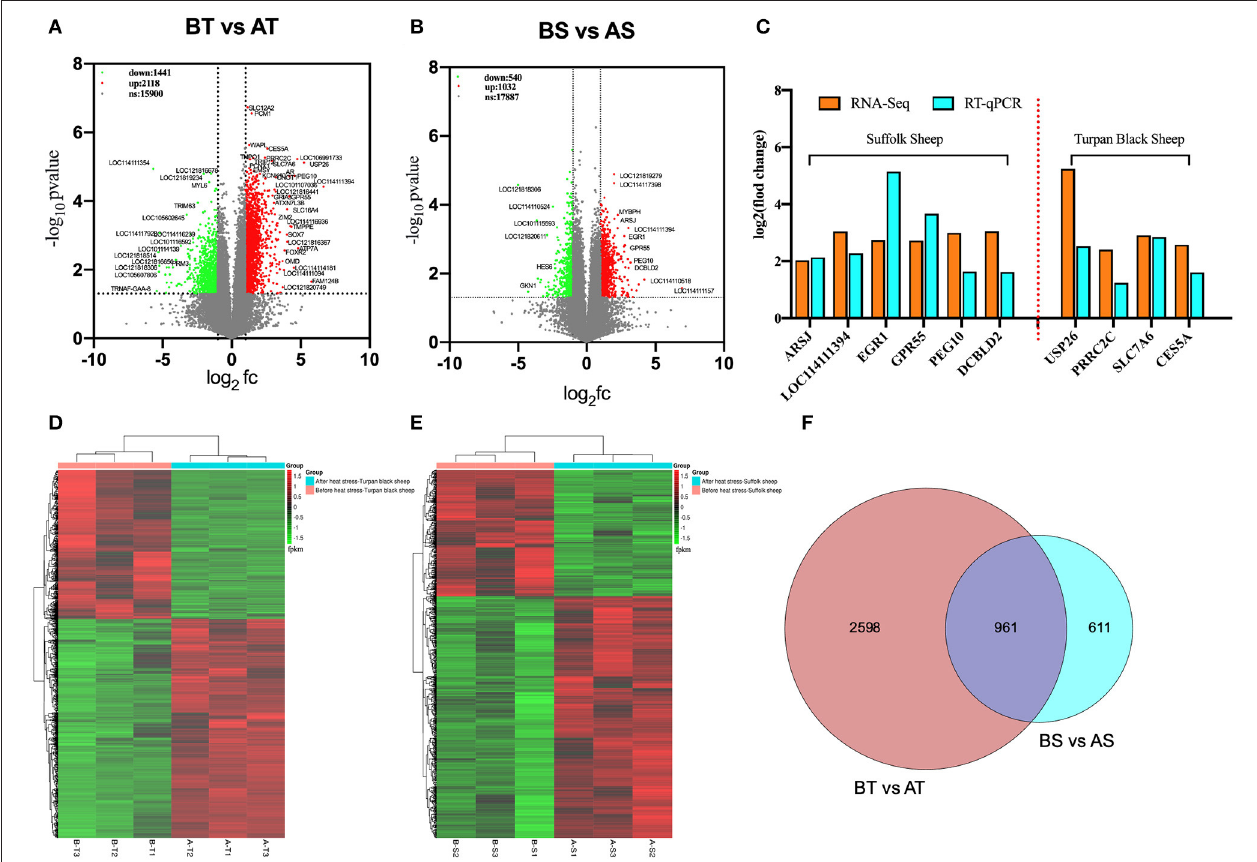
FIGURE 6 | Cluster analysis of differentially expressed genes in the testis transcriptome of Turpan black sheep before and after HS treatment. (A,D) Volcano map and heat map of testicular transcriptome differential genes in Turpan black sheep before and after HS. (B–E) Volcano plots and heat maps of differential genes in the testis transcriptome of Suffolk sheep before and after HS. (C) The trends of differentially expressed genes in RNA-seq and q-PCR. (F) Venn diagram representing the common differentially expressed gene distribution. In the volcano plot, red represents up-regulated genes, green represents down-regulated genes, and gray represents genes with no significant difference. The volcano plot showed that the differentially expressed genes satisfy the correction condition p < 0.05.